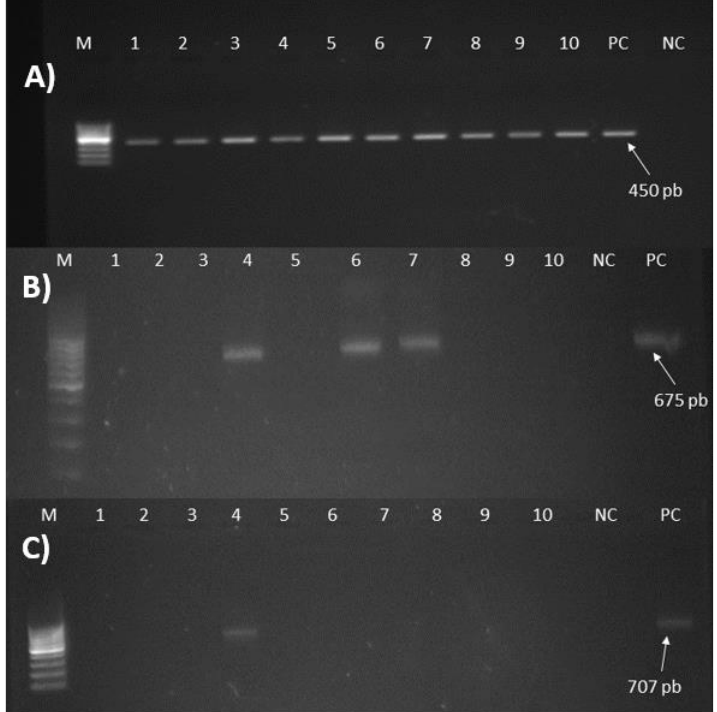
Figure 3. Amplification products of PCR tests targeting three different genes of Spiroplasma citri . Lane NC is a negative control; lane PC is a positive control; and lane M corresponds to the DNA ladder (Invitrogen, Waltham, MA, USA). ( A ) Products generated with the primer pair targeting the putative adhesion gene P58. Lanes 1–10: 10 samples tested positive. ( B ) Products generated with the primer pair targeting the spiralin gene. Lanes 3, 5, and 6: samples tested positive. Lanes 1–2, 4, and 7–8: samples tested negative. ( C ) Products generated with the primer pair targeting the putative